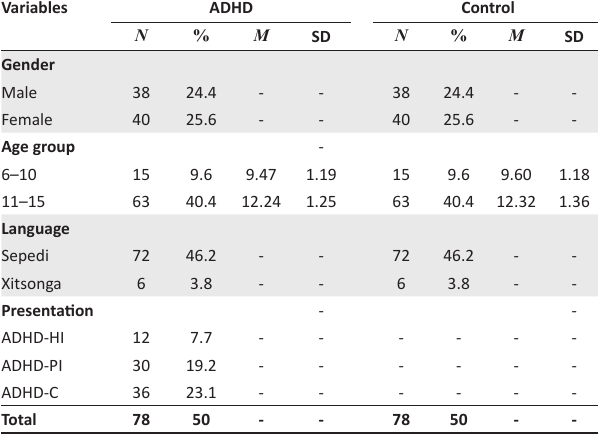
TABLE 1: Demographics of the sample ( N = 156). Variables ADHD